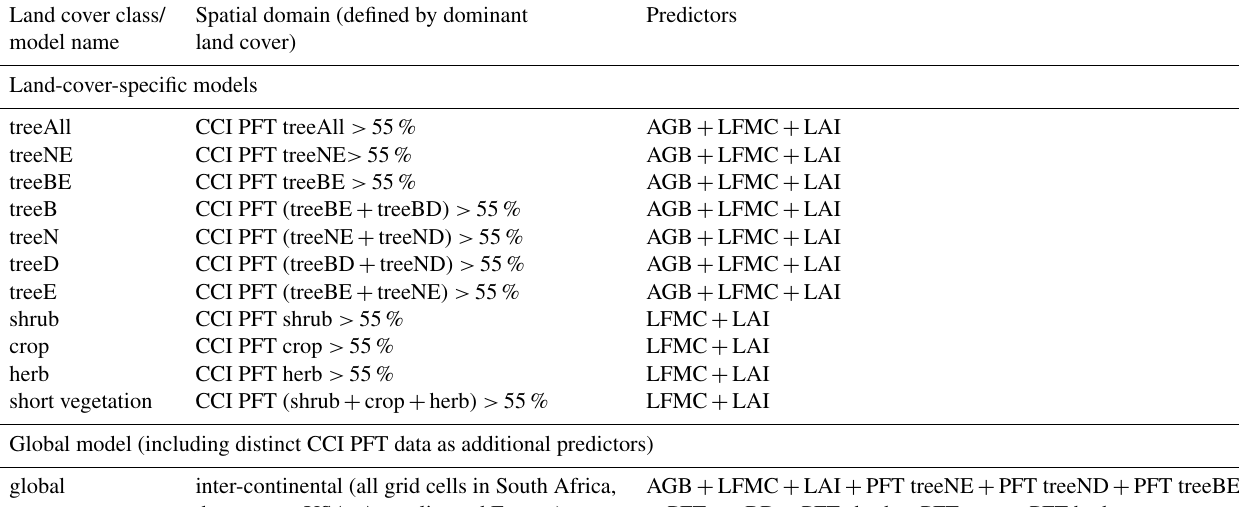
Table 2. List of tested models. N: needleleaf, B: broadleaf, E: evergreen, D: deciduous, All: not differentiated, CCI PFT: ESA Climate Change Initiative plant functional type. Each model is run with GAM and RF as well as with datasets with an 8-daily and monthly temporal resolution for each VOD dataset. The land-cover-specific models are only trained and tested within a cross-validation for pixels which are dominated by certain land cover (threshold PFT fraction >